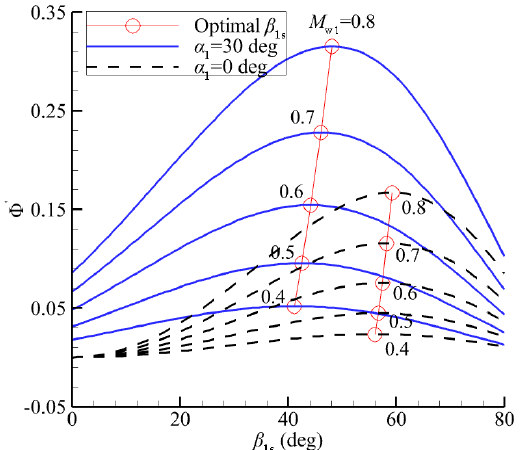
Figure 6. Modified mass flow function Φ (cid:48) versus inlet flow angle β 1 s for centrifugal impellers with di ff erent prewhirl angles based on Equations (18) and (19), where n s1 = 1.529.